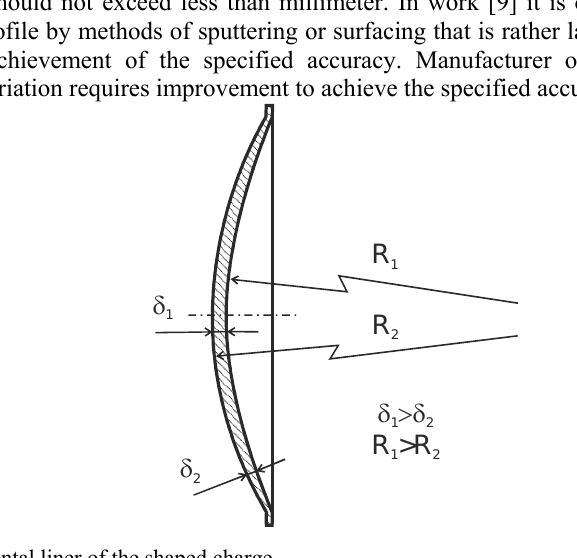
Fig. 1. Segmental liner of the shaped